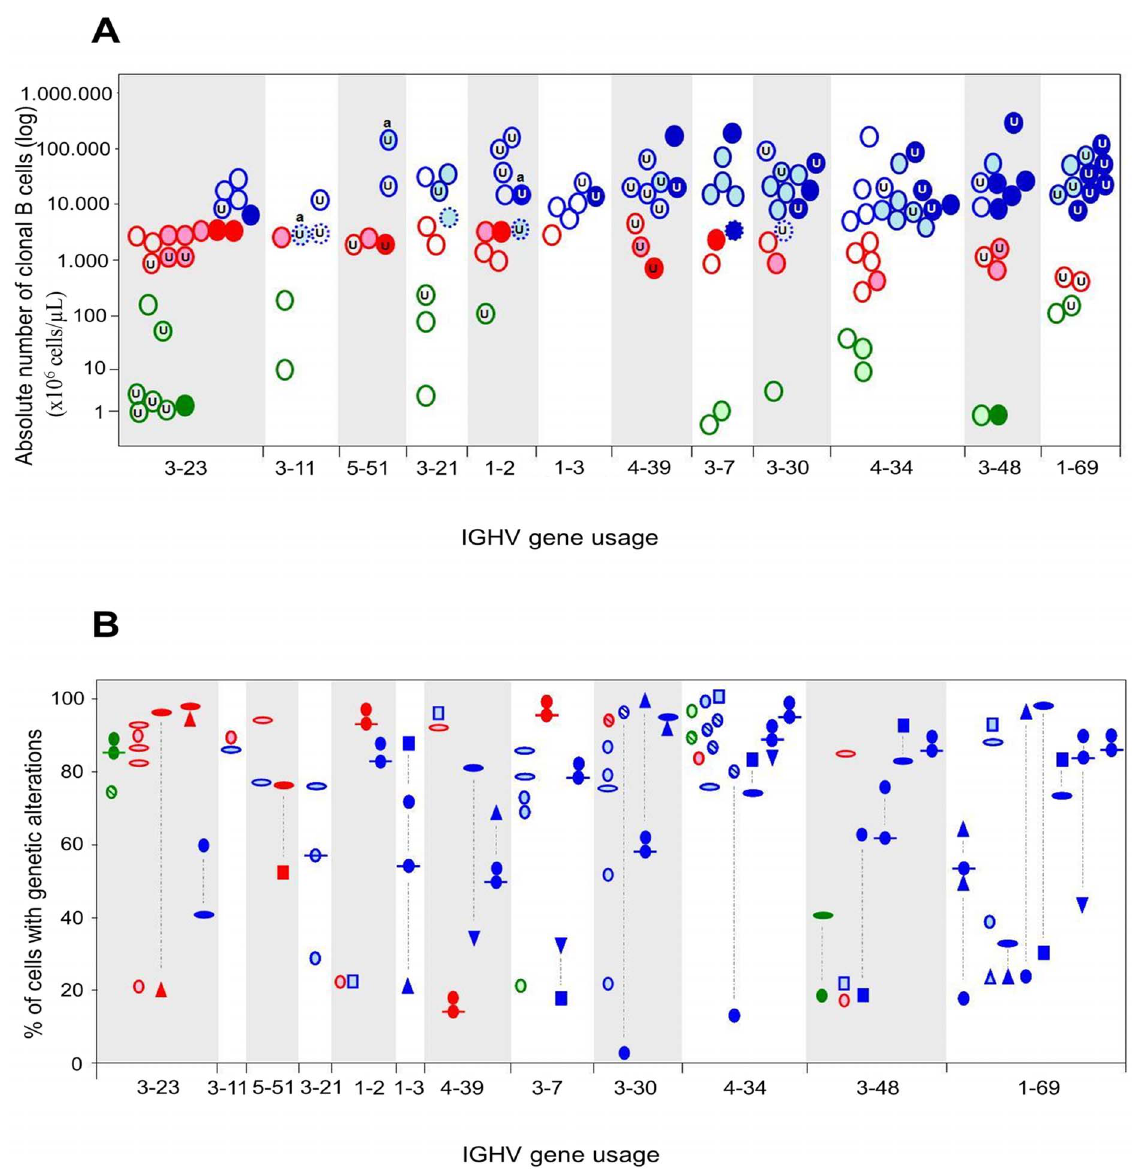
Figure 1. Frequency of CLL-associated cytogenetic alterations (A) and the cytogenetic profile (B) for those IGHV genes most commonly detected in ‘‘low-count MBL’’(MBL lo ), ‘‘high-count MBL’’ (MBL hi ) and CLL B-cell clones, as assessed by interphase fluorescence in situ hybridization (iFISH). The three diagnostic categories studied are depicted by different colors (green, MBL lo ; red, MBL hi ; blue, CLL B-cell clones) and the absence vs presence of one vs $ 2 chromosomal alterations per clone, is indicated by empty circles, light colored and dark colored circles, respectively. For each IGHV subgroup, the clones are represented in the Y-axis according to the absolute number of clonal B cells per m L of PB ( A ) and the percentage of cells genetically altered, by iFISH ( B ). Different FISH patterns are defined by the following symbols in panel B :, del(13q14.3);, biallelic del(13q14.3);, del(13q14);, trisomy 12; D , del(11q); , , del(17p) and; % , t(14q32); dotted contour lines in panel A highlight those clones phenotypically classified as SLL(small lymphocytic lymphoma); dotted blue lines in panel B indicate cells from the same B-cell clone showing different cytogenetic abnormalities; U=unmutated clones; a=clones with NOTCH1 mutation.